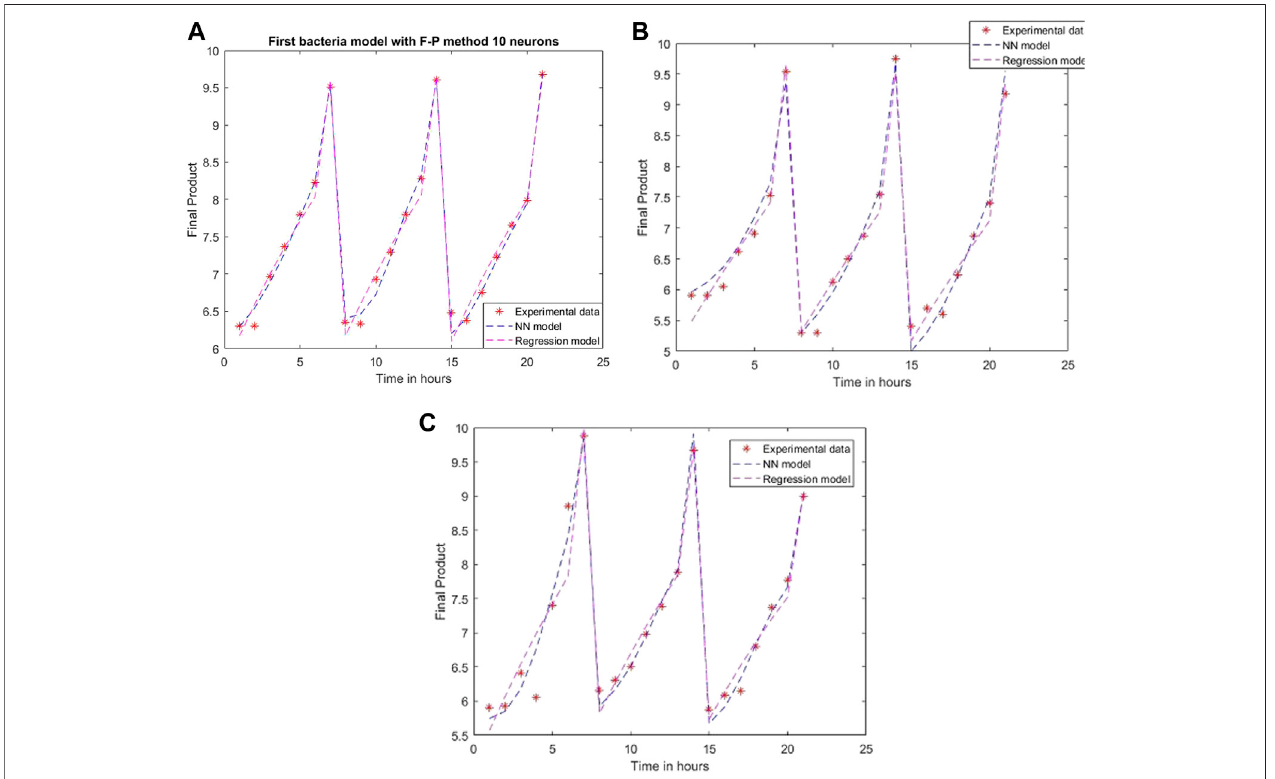
FIGURE 8 | Model results with Fletcher-Powell method and 10 neurons for (A) L. plantarum ; (B) L. casei ; (C) co-cultures of L. plantarum and L. casei .